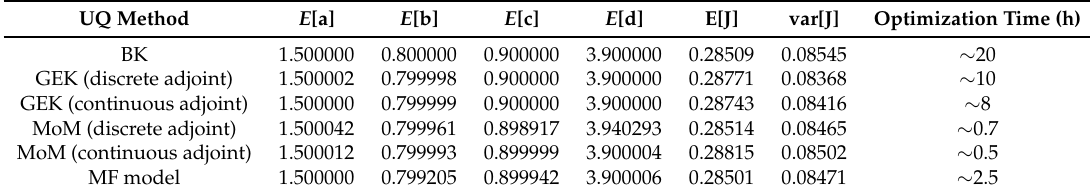
Table 4. Optimal solutions of RDO according to the various strategies.